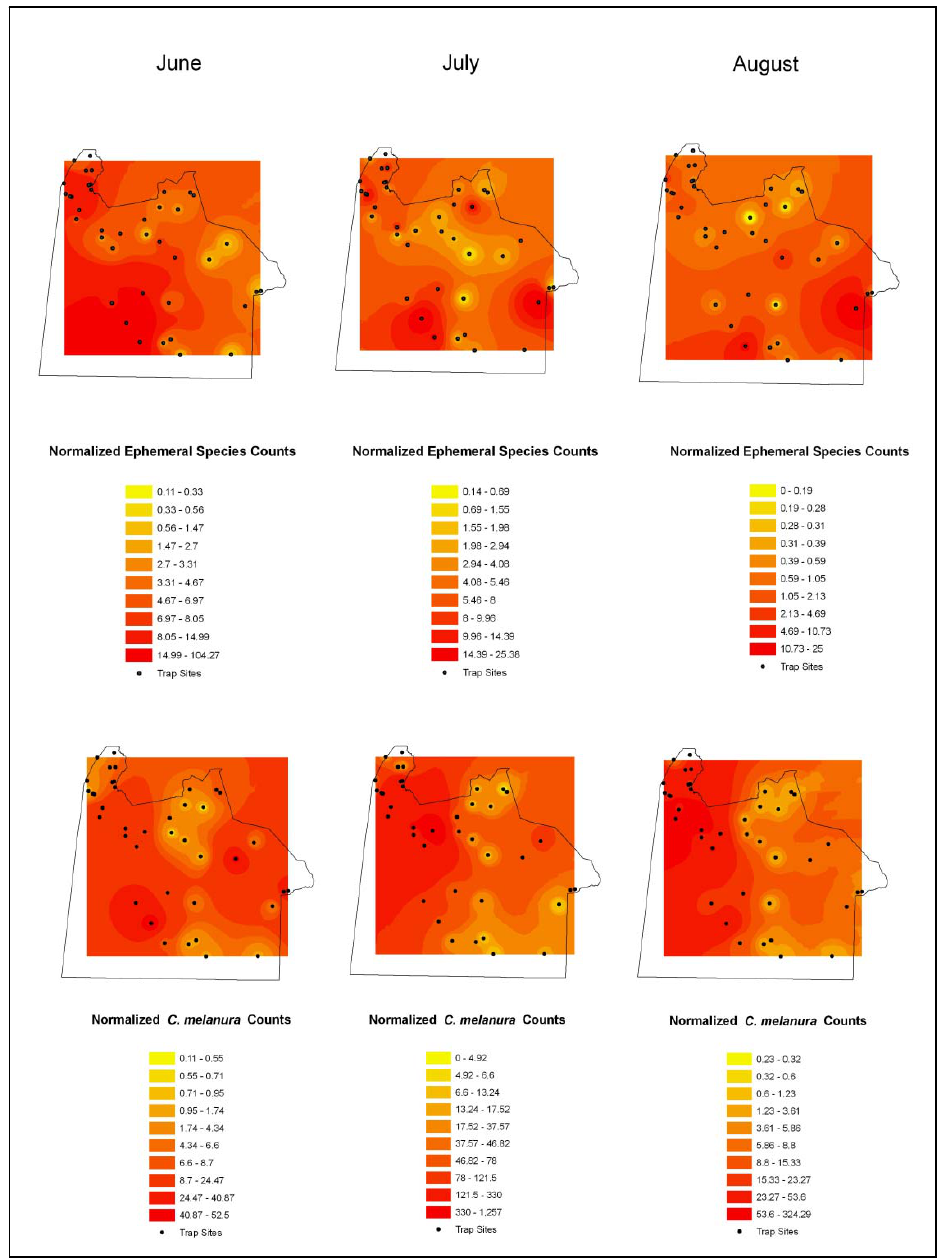
Figure 7. Interpolated surfaces of the normalized monthly trap counts for the ephemeral species symbolized using a quantile